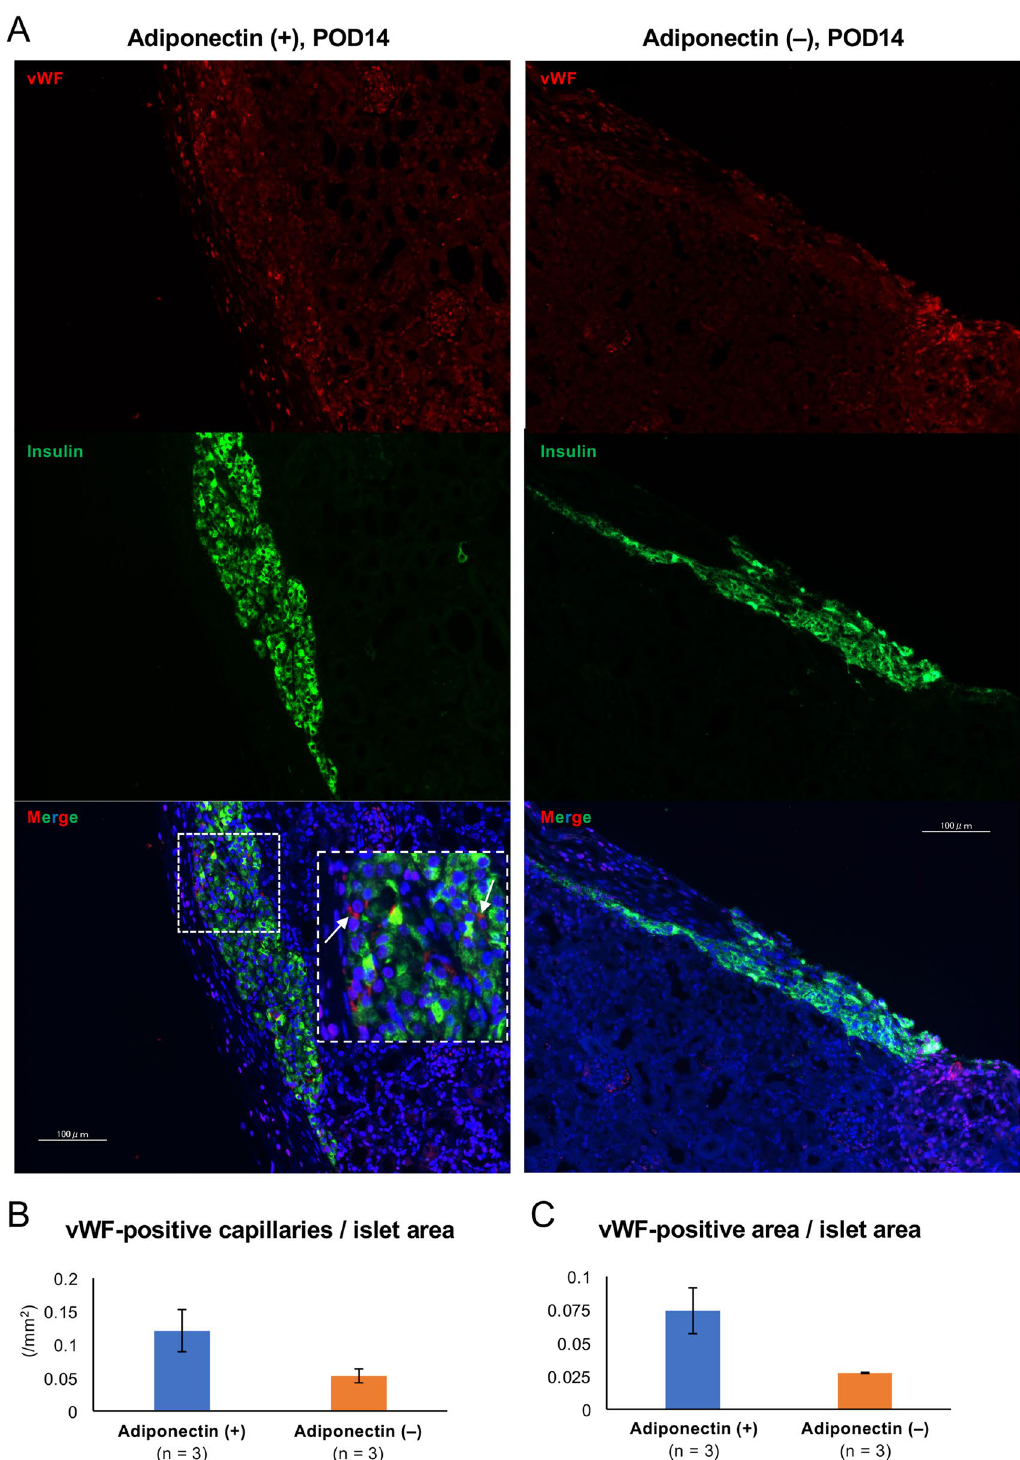
Figure 3. Angiogenesis in transplanted islets. ( A ) Immunohistochemical findings of transplanted islets in the renal subcapsular space at POD 14. Islets treated with adiponectin (adiponectin (+), left) and without adiponectin (adiponectin (−), right) were stained for insulin (green) and vWF (red, indicated by arrows). DAPI was used for nuclear staining (blue). ( B ) Vessel densities, defined as the number of vWF-positive capillaries per islet area, at POD 14. ( C ) Vessel densities, defined as the vWF-positive area per islet area, at POD 14. Data are presented as means ± standard error of the mean. A p -value < 0.05 was considered statistically